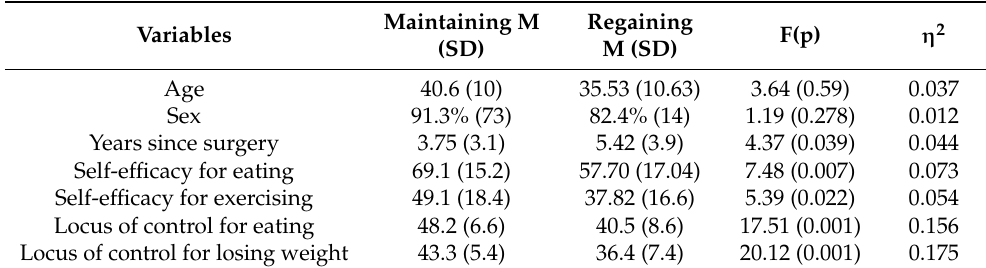
Table 4. Means (M), standard deviation (SD), and results of the one-way multivariate analysis, for self-efficacy and LC, in accordance with current weight status.